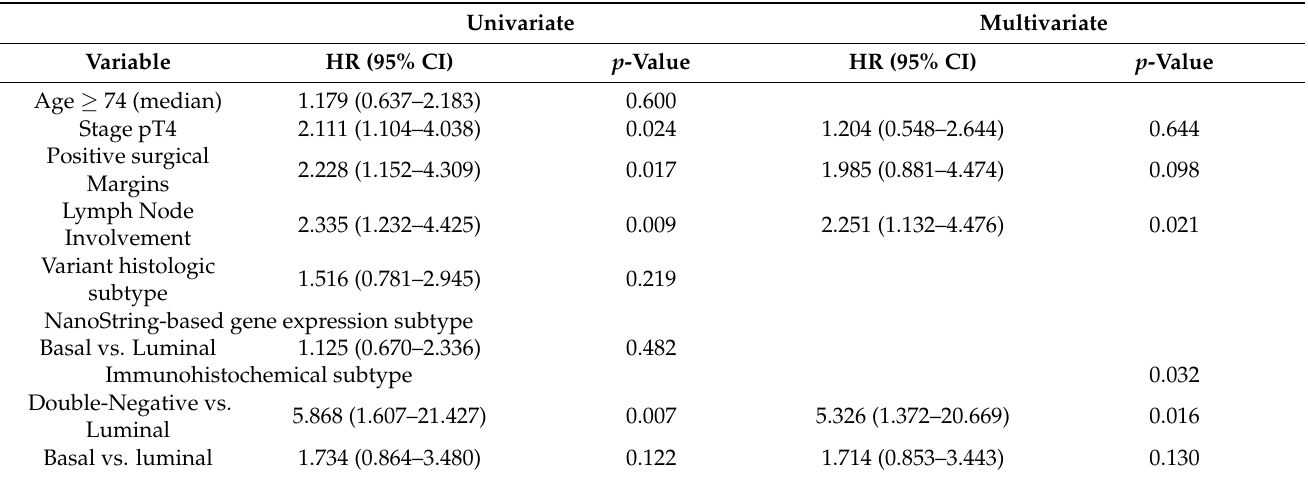
Figure 3. ( A ) Kaplan–Meier plots and log-rank p -values correlating the three immunohistochemical molecular subtypes with recurrence-free survival; ( B ) and disease-specific survival. Table 1. Univariate and multivariate analysis of clinic-pathological parameters related to cancer-specific survival prediction in the current study.